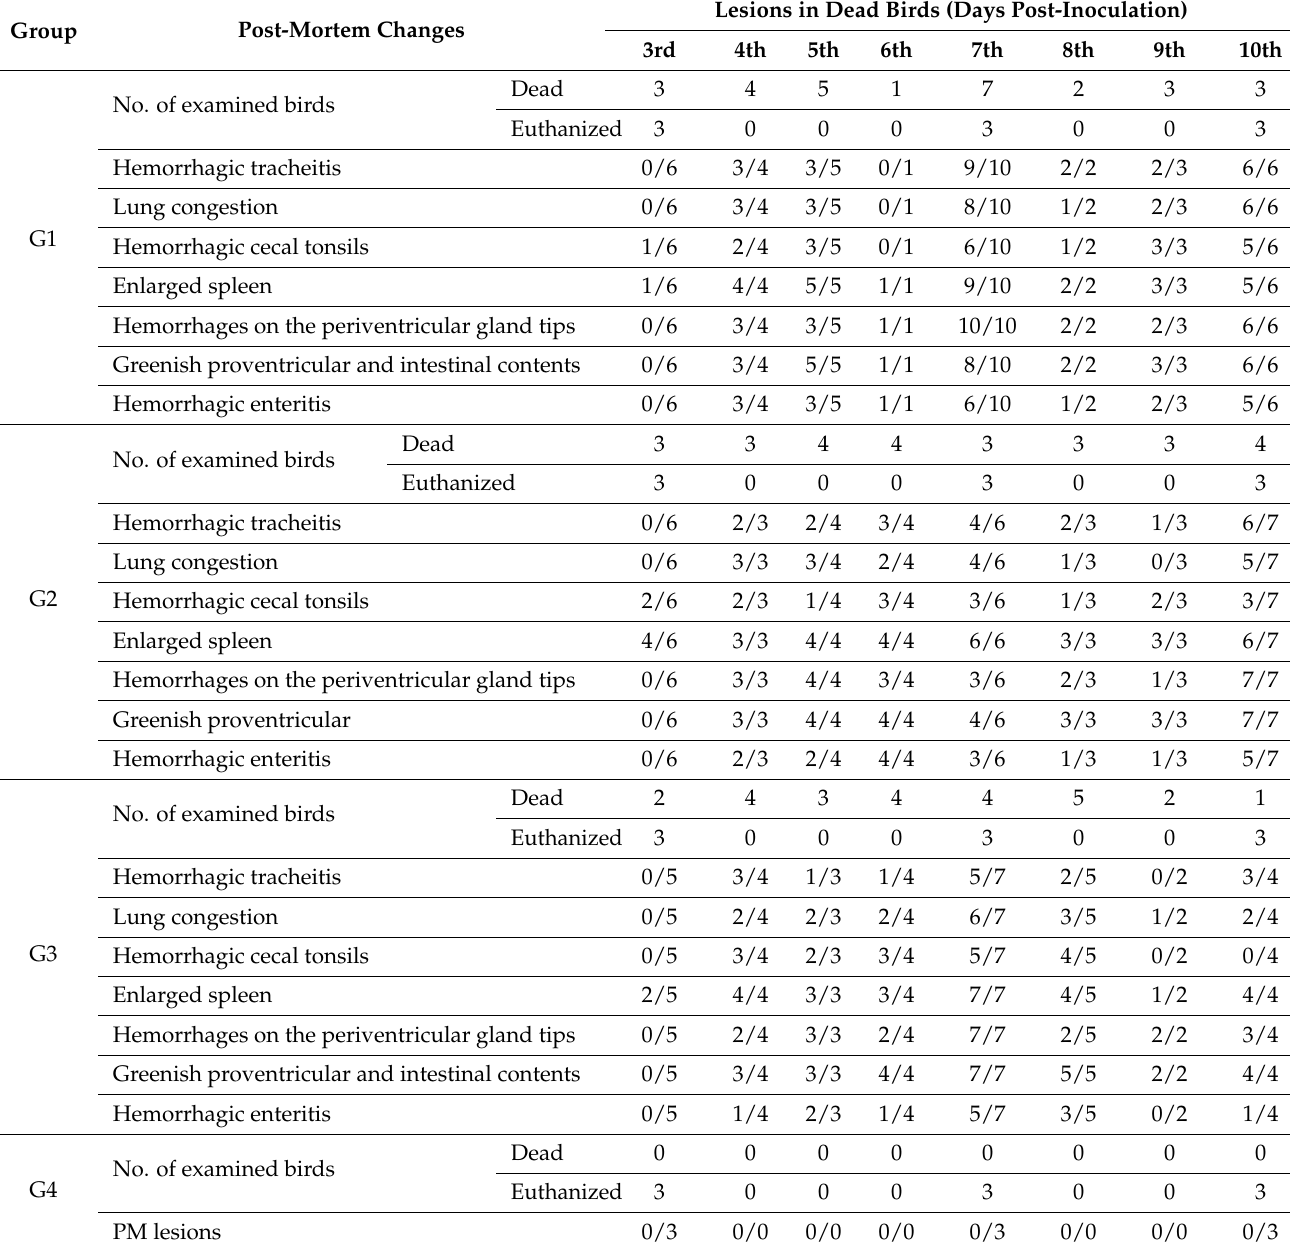
Table 5. Post-mortem changes reported in susceptible chickens following pathogenicity